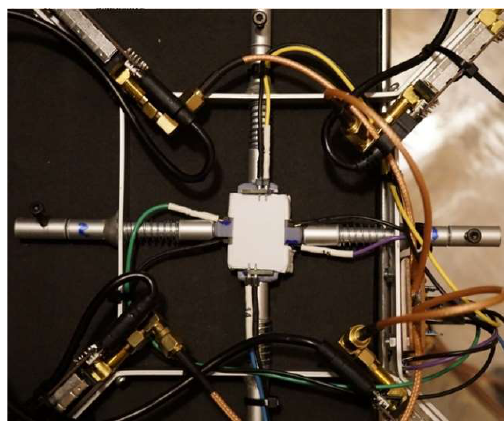
Fig. 7. The instrumented first “ TaraT ” prototype. The d - stilbene scintillator has been provided by